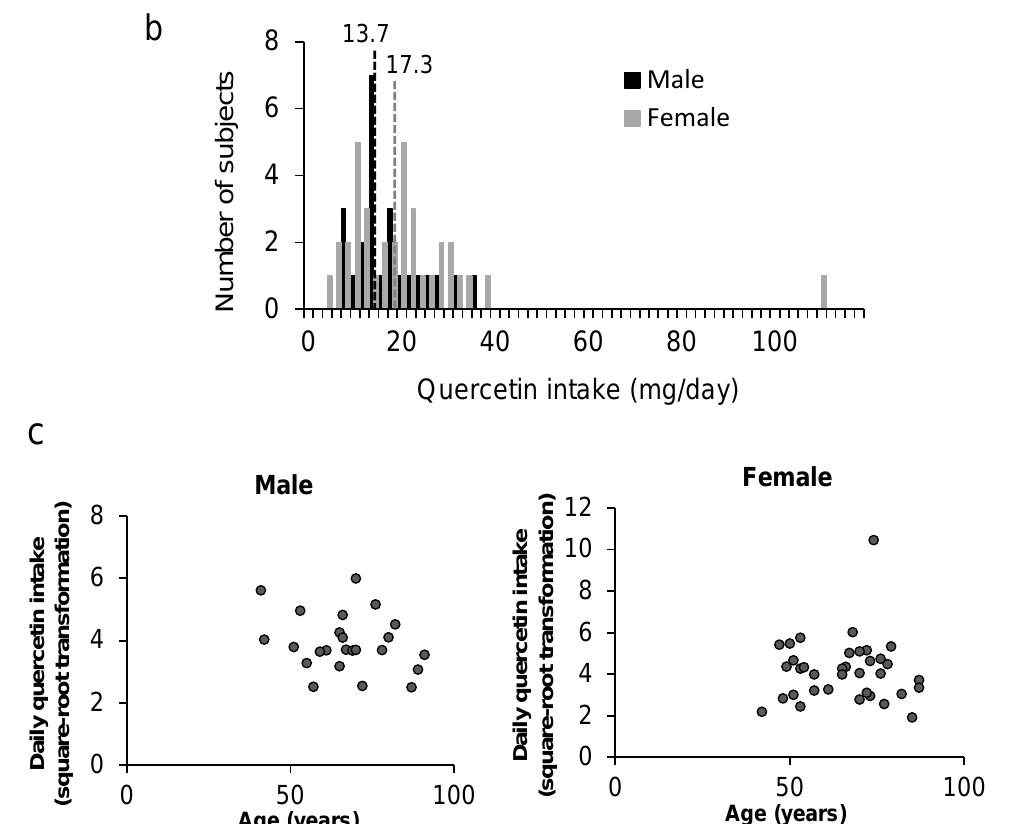
Figure 4. ( a ) Estimated daily quercetin intake by 60 residents of Sobetsu in Hokkaido using the FFQ during winter. ( b ) Estimated daily quercetin intakes by men and women using the FFQ during winter. Numbers in the figure show the median quercetin intakes by men and women. ( c ) Relationship between quercetin intakes by men or women and their